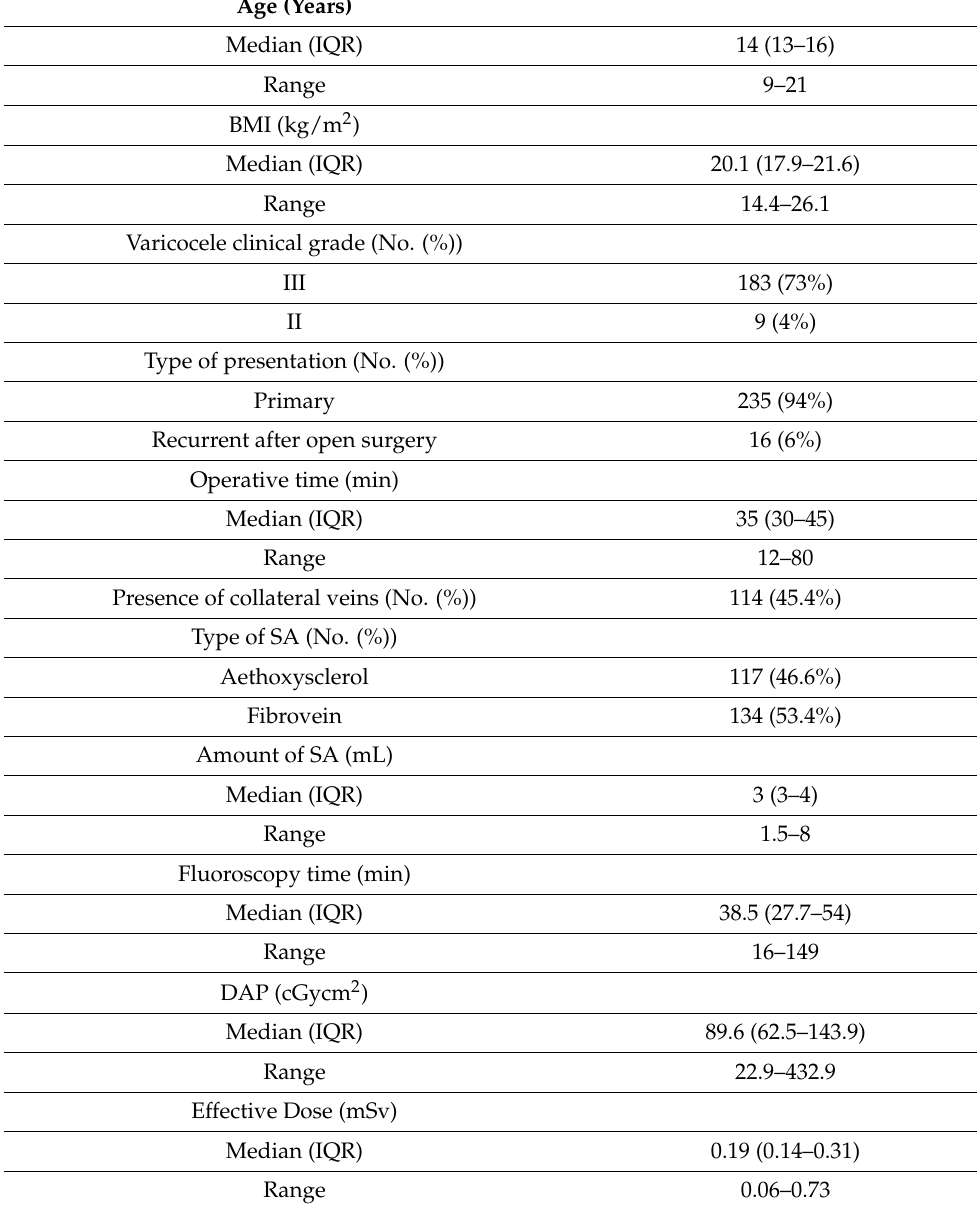
Table 1. Demographics and peri-operative characteristics of the study cohort (No. =